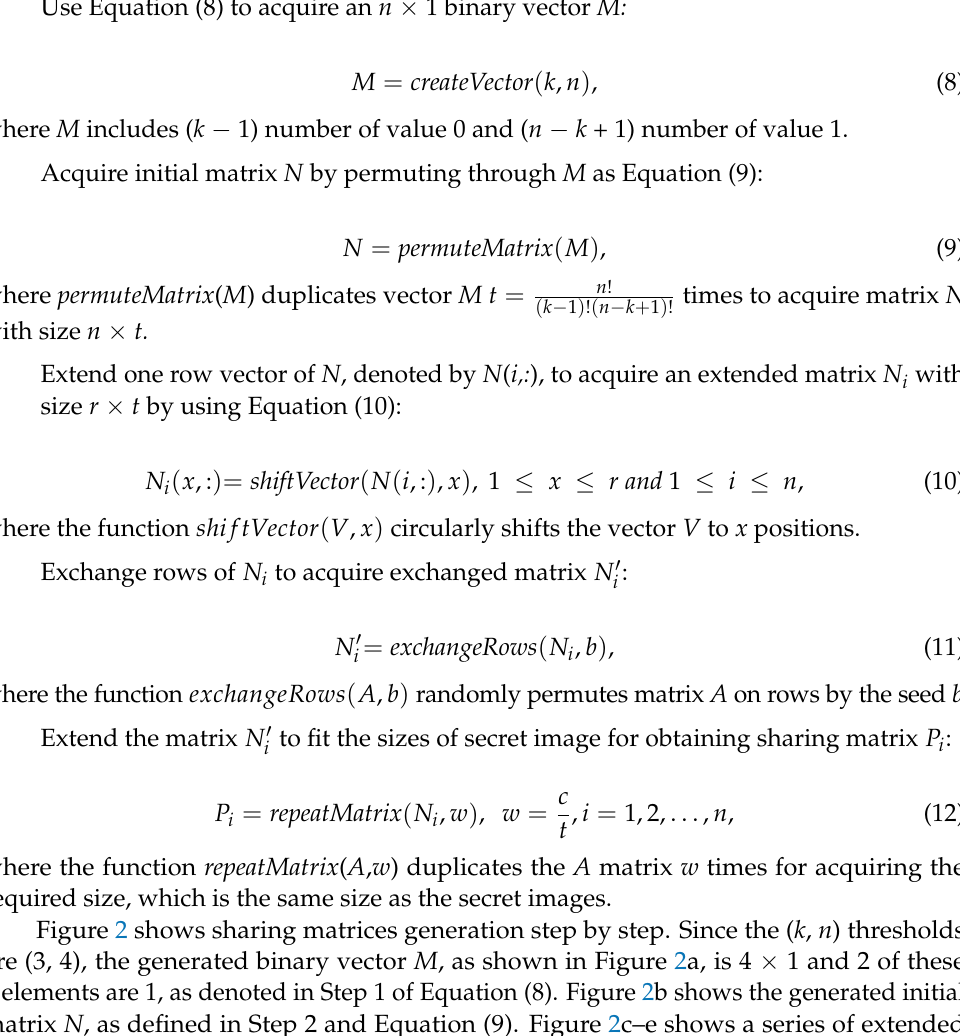
with r × c secret image